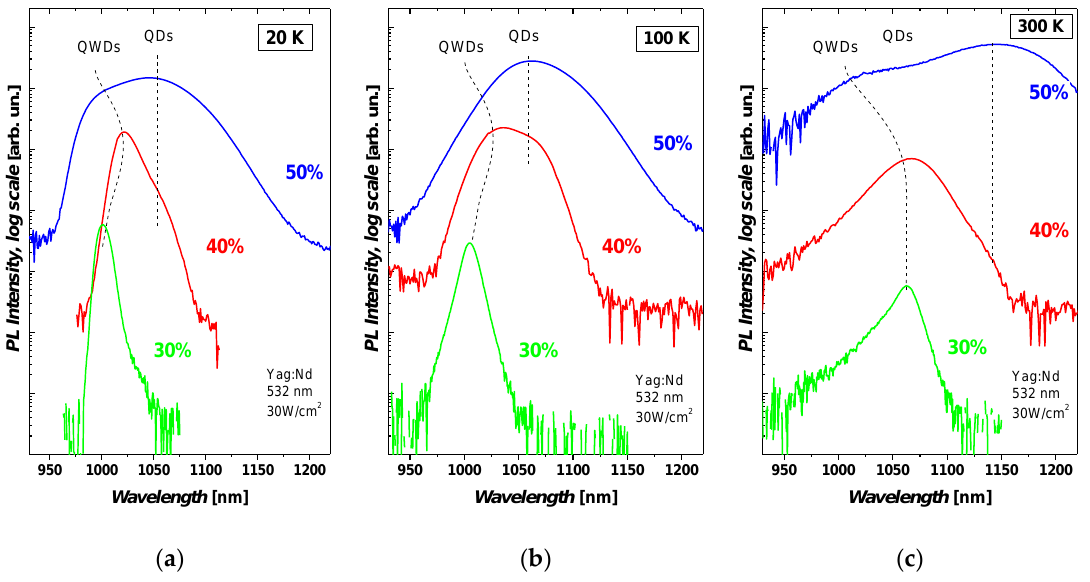
Figure 6. PL spectra of InGaAs QWDs with 30%, 40%, and 50% In composition measured in the conditions of random carrier population — 20 K ( a ), one-way carrier transport — 100 K ( b ) and equilibrium (Fermi) carrier distribution — 300 K ( c ) in joint QWD/QD array.